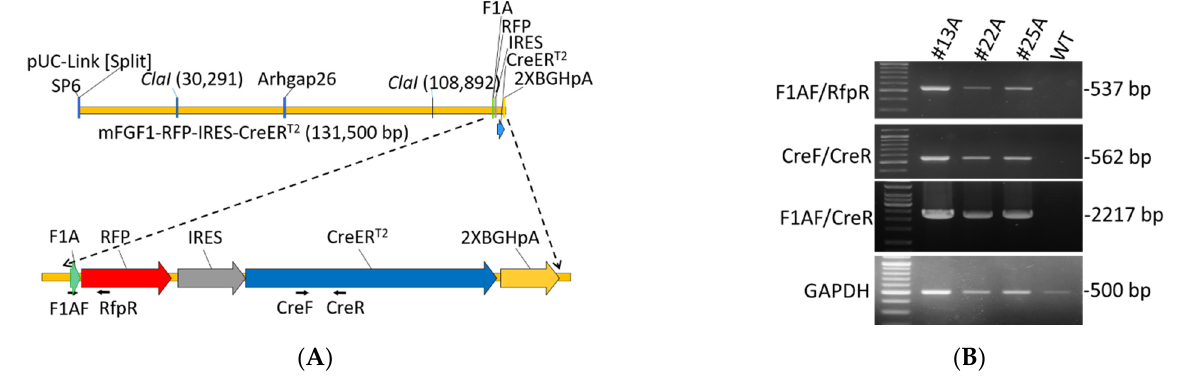
Figure 1. Construction map and genotyping of F1A-CreER T2 transgenic mice. ( A ) Construction map of F1A-CreER T2 transgenic mice. The transgene of F1A-RFP-IRES-CreER T2 was constructed using mouse Fgf1A promoter including Fgf1A promoter sequence comprising 127.7 kb of upstream sequences, followed by 714 bp of RFP gene sequences, 536 bp of IRES gene sequences, and 2001 bp CreER T2 sequences. Primers designed for genotyping: F1AF, RfpR, CreF and CreR. ( B ) Genotyping results of three F1A-CreER T2 founders: #13A, #22A and #25A. The amplicon of primer F1AF/RfpR is 537 bp; F1AF/CreR is 2,217 bp, and CreF/CreR is 562